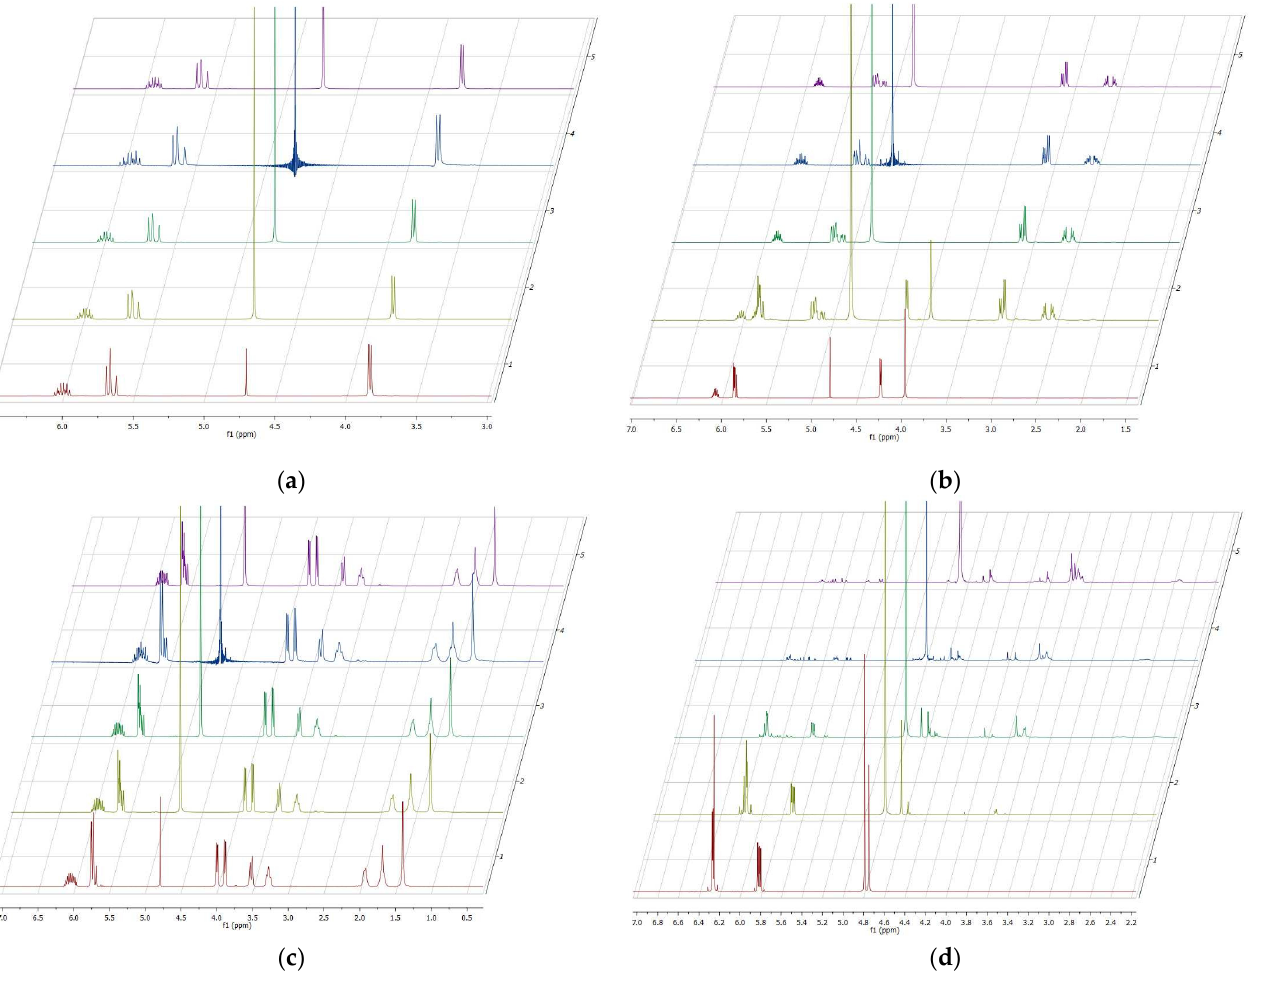
Figure 2. 1 H-NMR spectra of the pure crosslinkers in 1 M KOH solution in D 2 O over the course of 7 days: ( a ) tetraallyl ammonium bromide , ( b ) N,N,N’,N‘ -tetraallyl piperazinium dibromide, ( c ) N , N , N ‘, N ‘-tetraallyl trimethylene dipiperidine dibromide, ( d ) BIS . The numbers on the right axis indicate the time code: (1) reference spectrum without KOH, (2) 1 M KOH in D 2 O on the same day, (3) after 24 h, (4) after 48 h, (5) after 7 days.